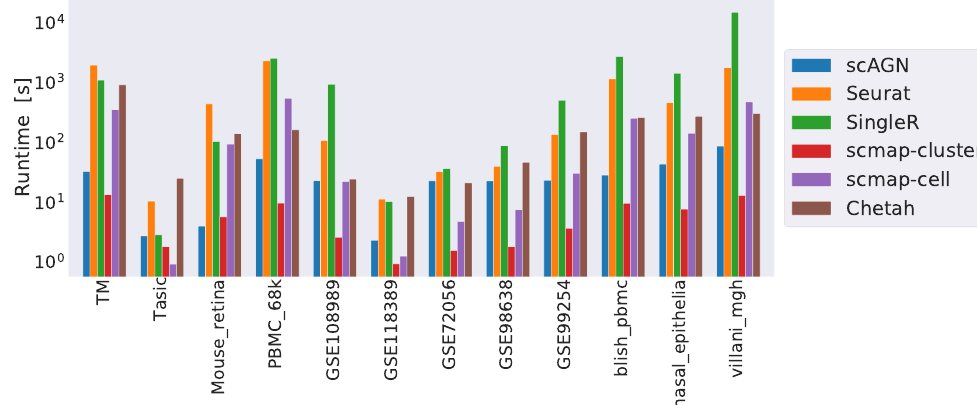
Figure 10. Runtime complexity of various classifiers included in our study. While scMAP-cluster was the fastest method, scAGN came second. SingleR was the slowest method. The y-axis is log-scaled for